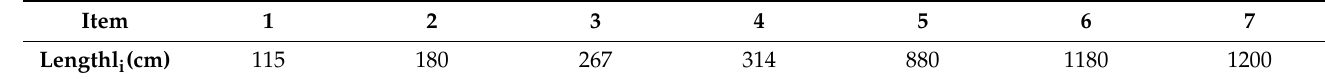
Table 1. Lengths of seven items.